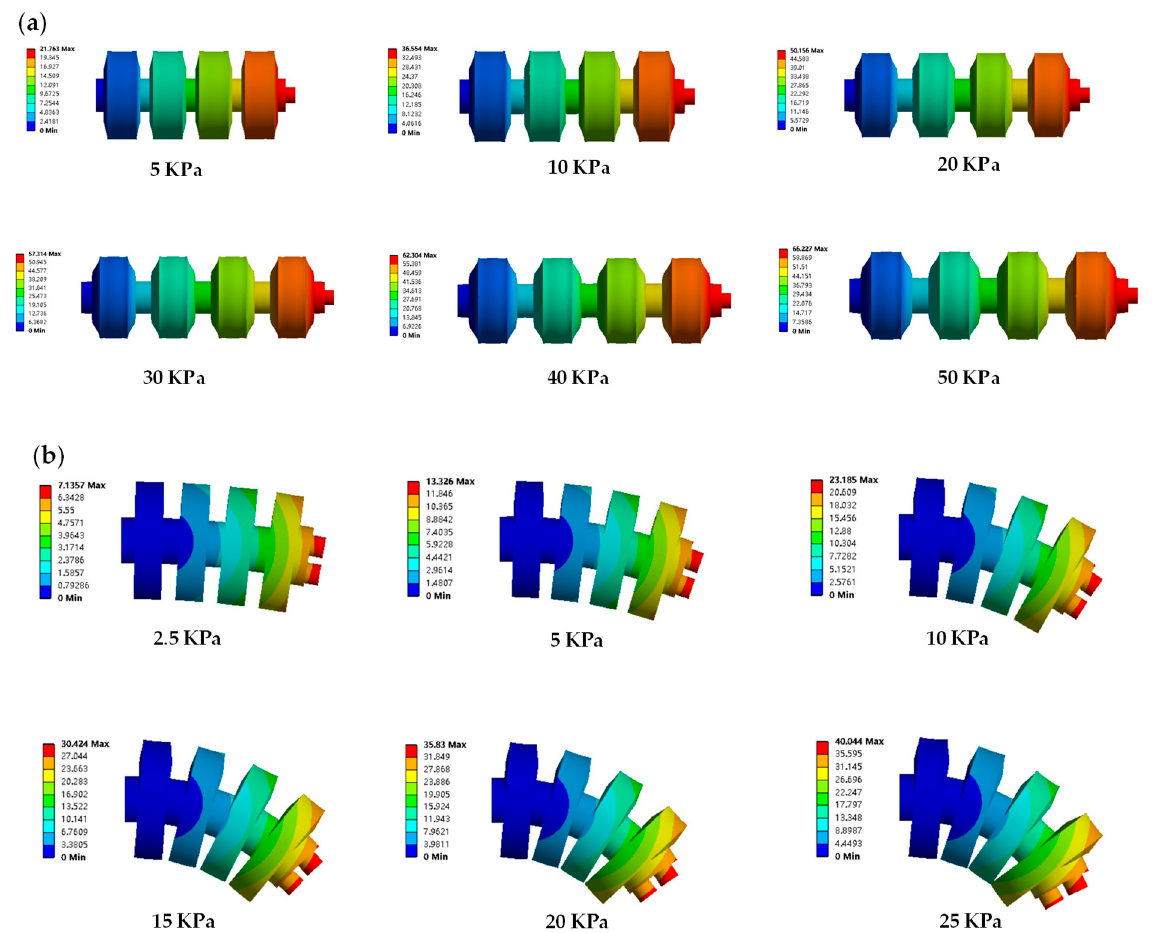
Figure 13. Deformation results in ANSYS Workbench. ( a ) Single-channeled actuator under the pressure of 5-30 KPa. ( b ) Double-channeled actuator under the pressure of 2.5–25 KPa.